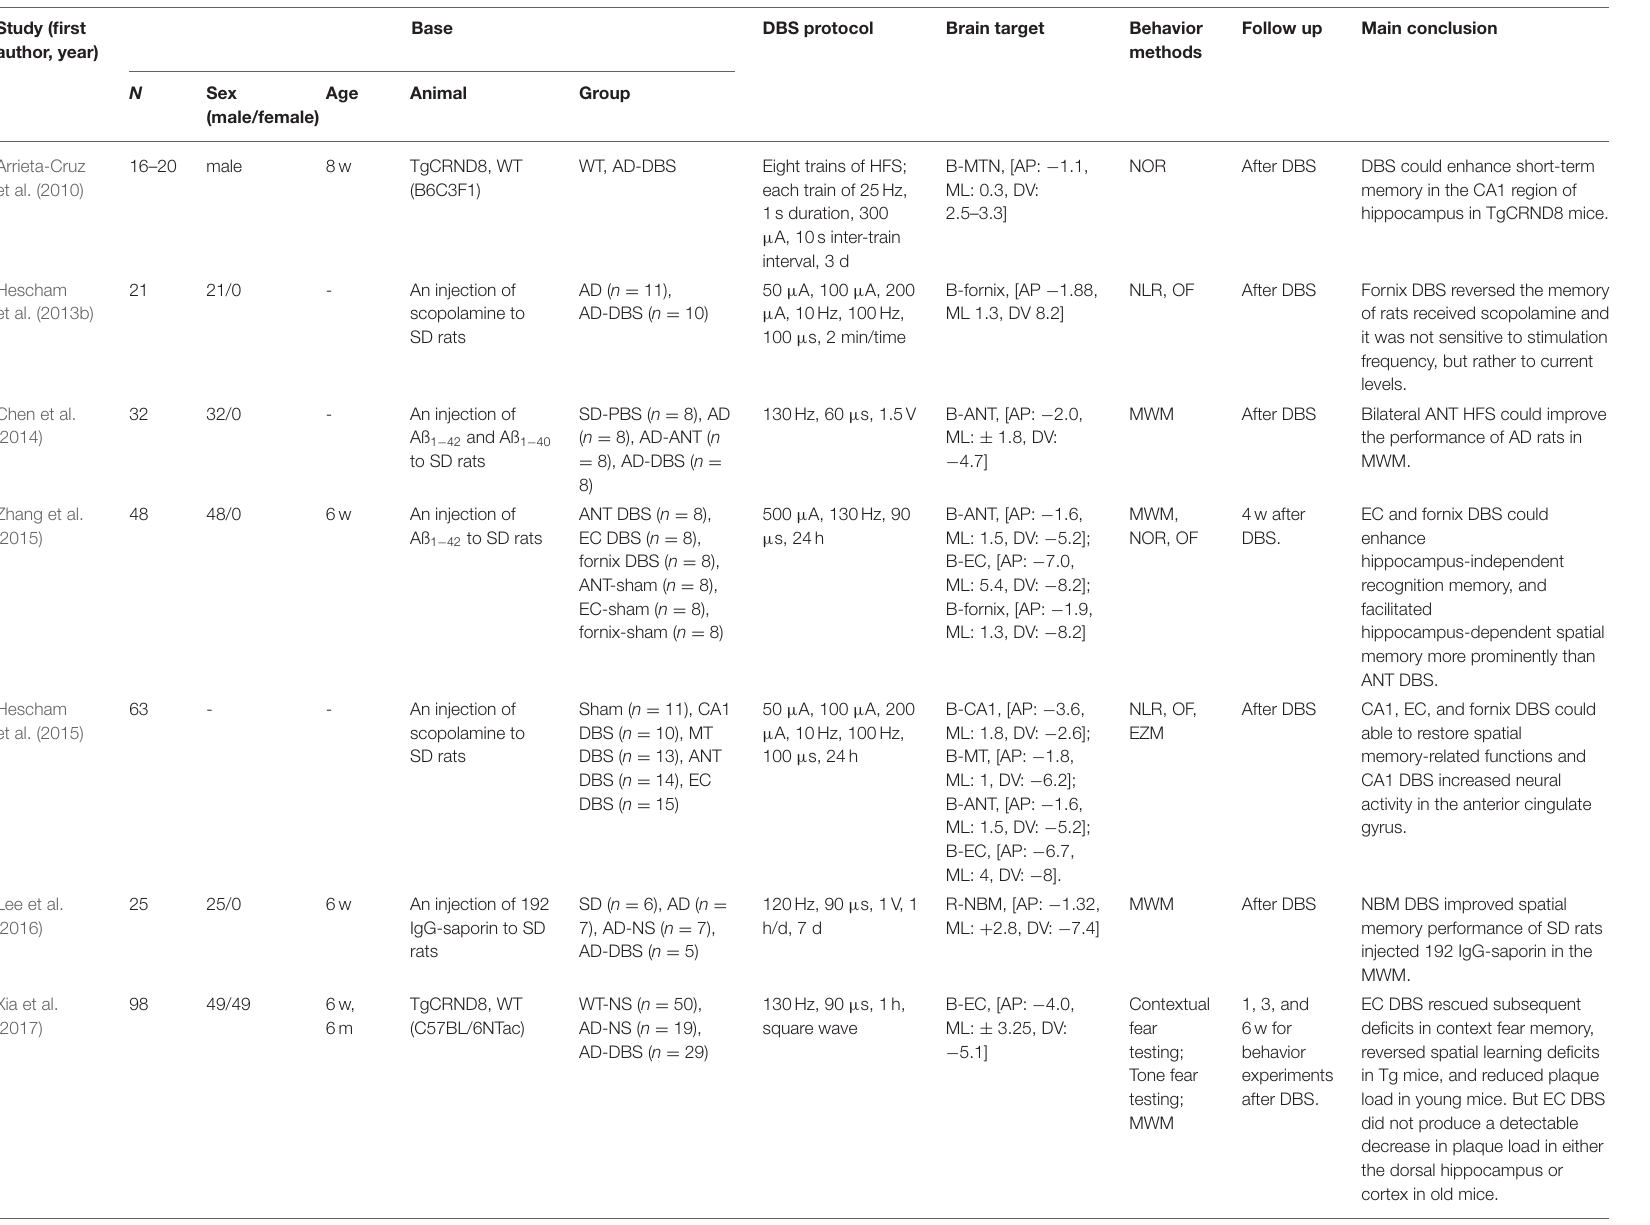
TABLE 2 | The animal study of DBS in